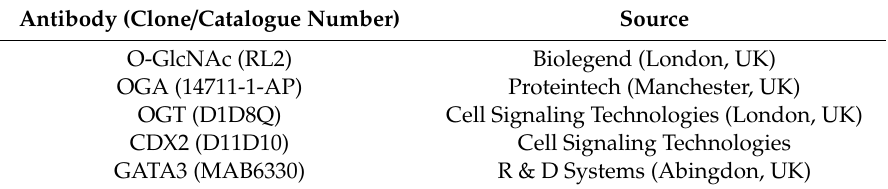
Table 1. Details of antibodies used in this